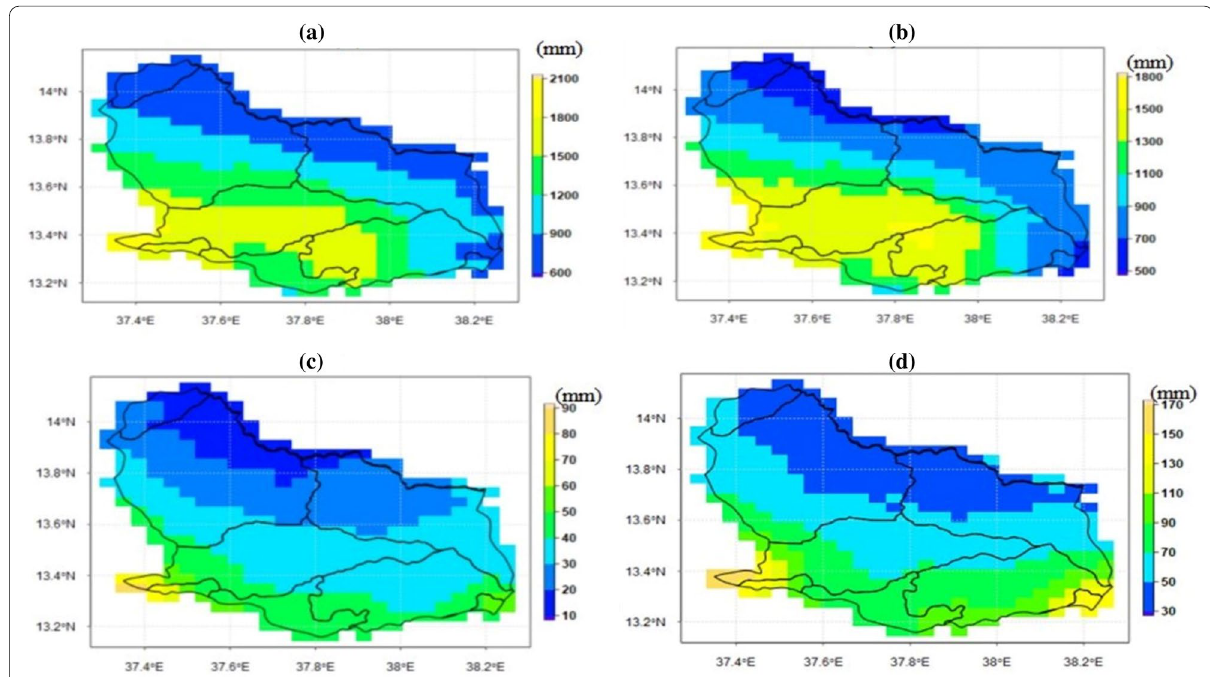
Fig. 6 Spatial representation of mean annual rainfall ( a ), Kiremit ( b ), Bega ( c ), Belg ( d ) seasons rainfall at Zarima